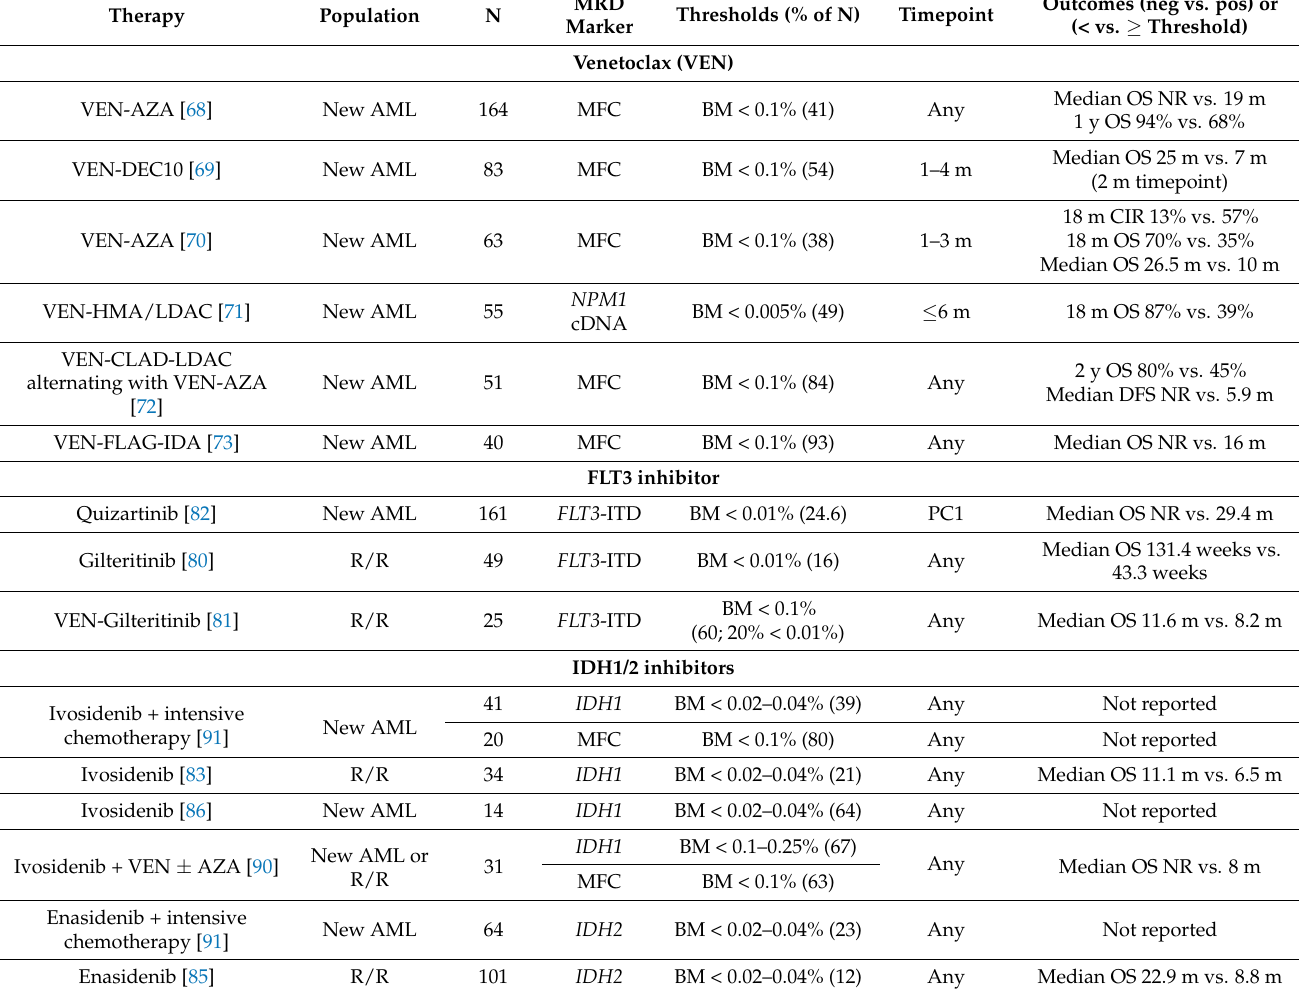
Table 3. Impact of novel therapies on MRD